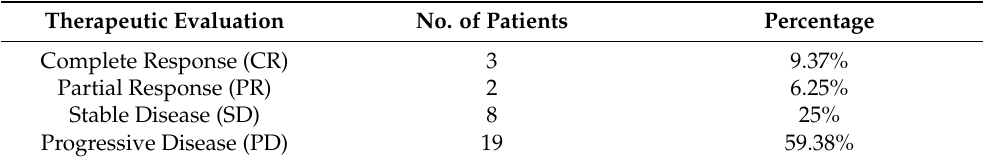
Table 7. Outcome of 32 patients after MDT discussion of treatment